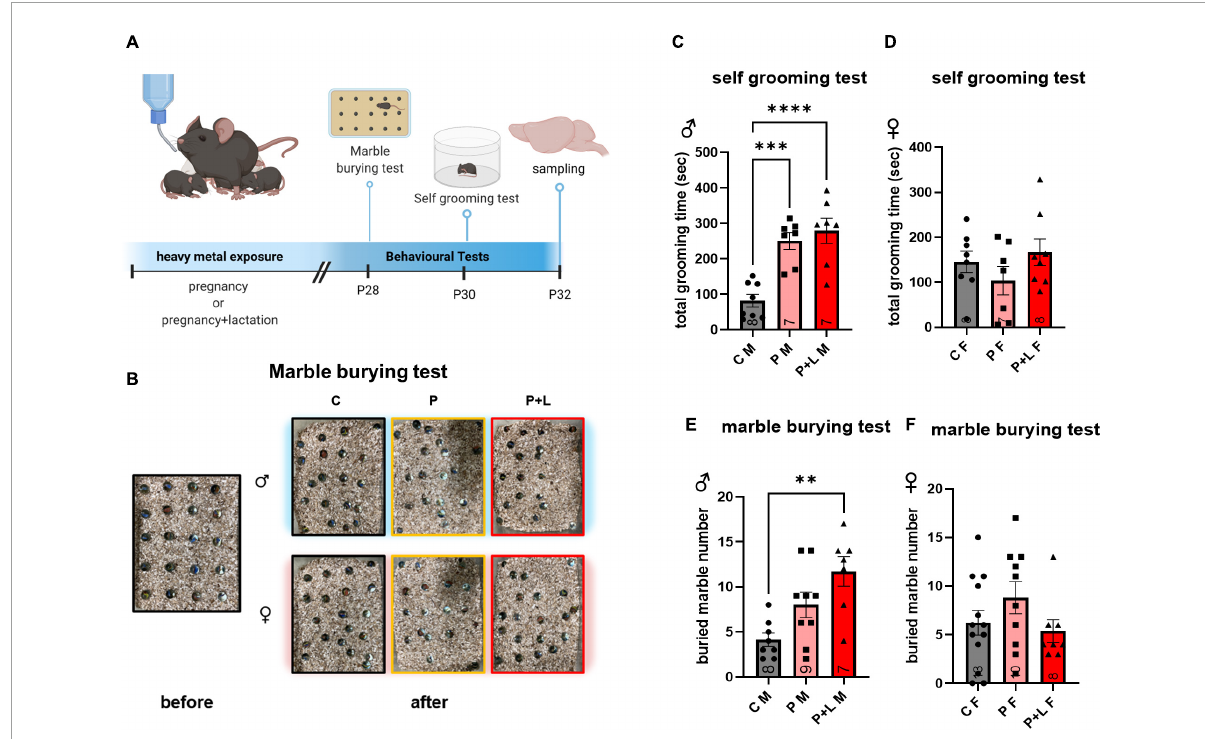
FIGURE2 Cerebellar developmental deficit induced repetitive behavior in male offspring. (A) Schematic diagram of behavior test. Offspring started to perform behavioral test at PND28. All the experience were finished, offspring were sacrificed to collect cerebellum sample. (B) Representative results of marble burying test. (C–F) Statistic analysis of behavior test in offspring. Data were analyzed with one-way ANOVA and expressed as mean ± SEM. (C) Result of self-grooming test in male offspring. Lead-exposed male offspring groups significantly increased self-grooming compared to control. [ N = 8 (C), 7 (P), 7 (P + L)]. ∗∗∗ p < 0.001, ∗∗∗∗ p < 0.0001. (D) Result of self-grooming test in female offspring. Female offspring did not show increased self-grooming. [ N = 8 (C), 9 (P), 7 (P + L)]. (E) Result of marble burying test in male offspring. P + L group was shown significant elevation of buried marble number. [ N = 8 (C), 7 (P), 8 (P + L)]. ∗∗ p < 0.01. (F) Result of marble burying test in female offspring. Any significant increase was not shown in female offspring. [ N = 13 (C), 10 (P), 8 (P +